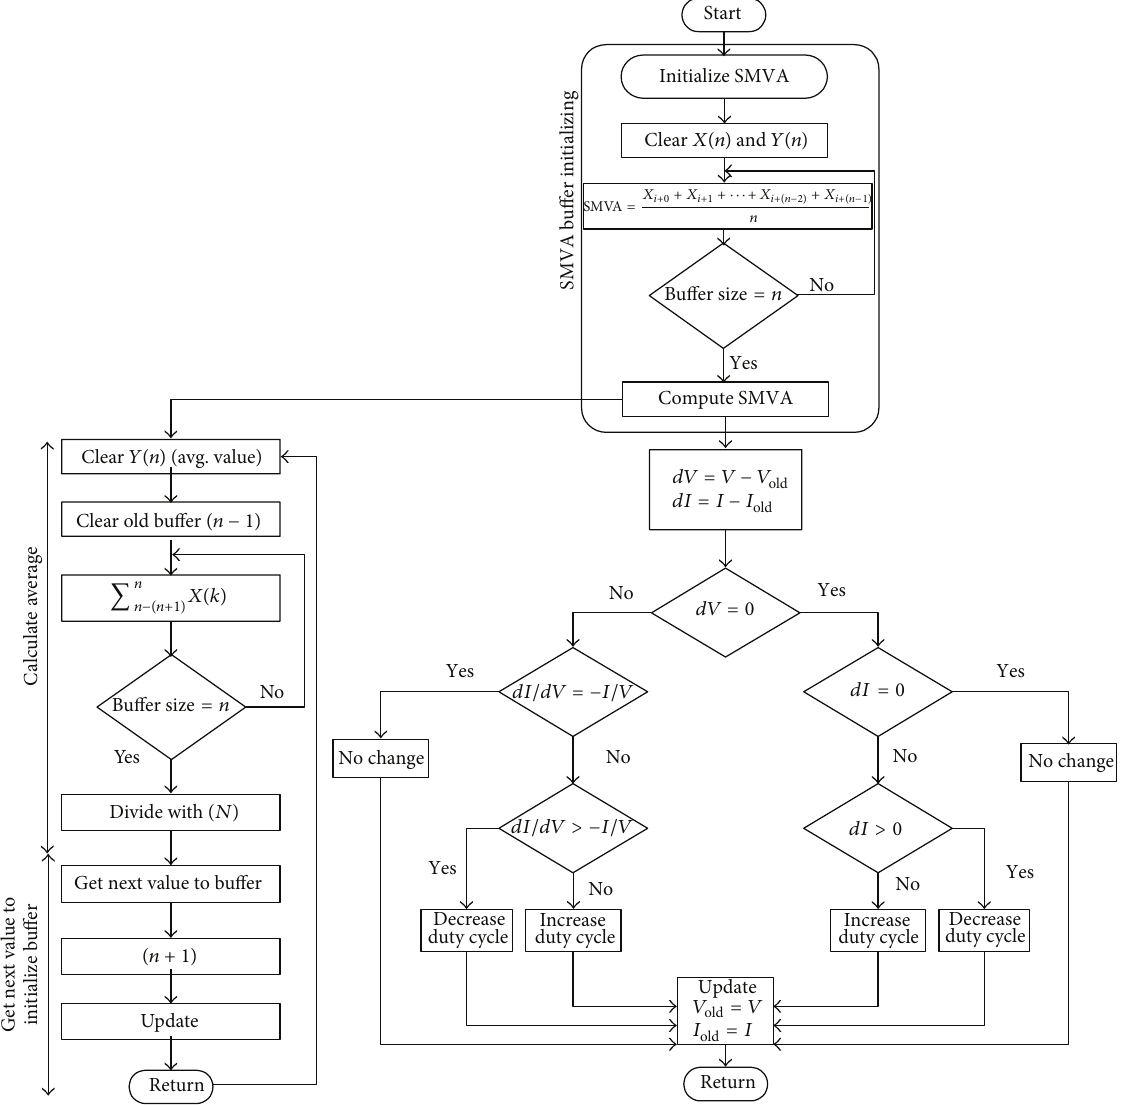
Figure 4: Flow chart of proposed simple moving voltage average (SMVA) model with direct control incremental conductance.